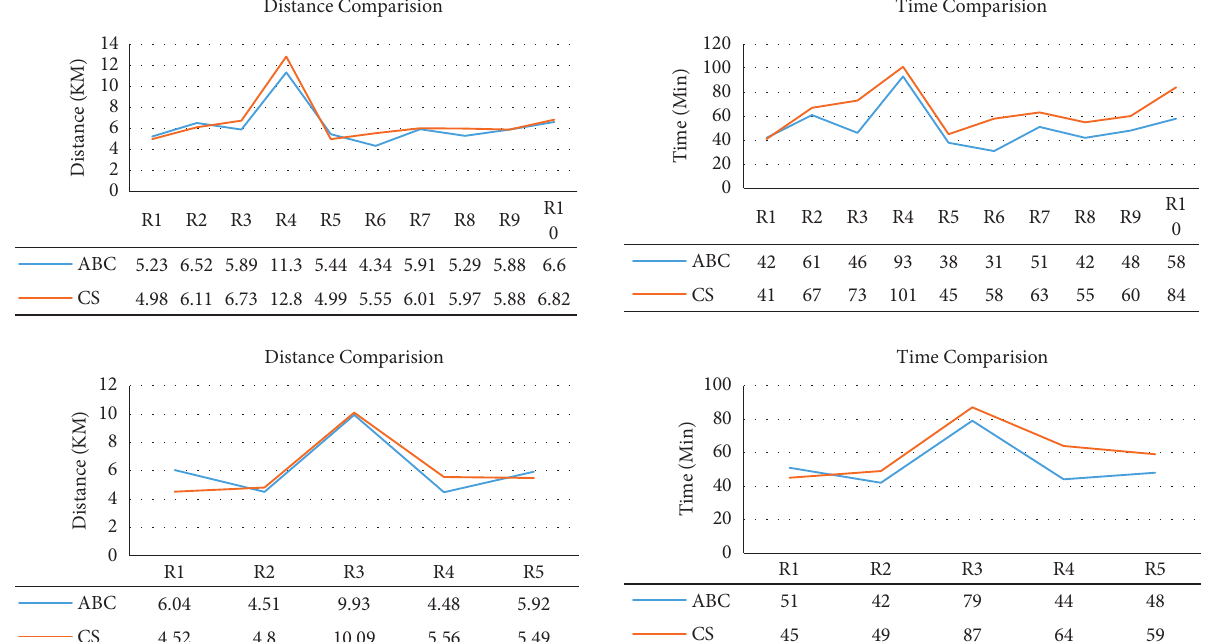
Figure 4: Comparison of distance travelled and time